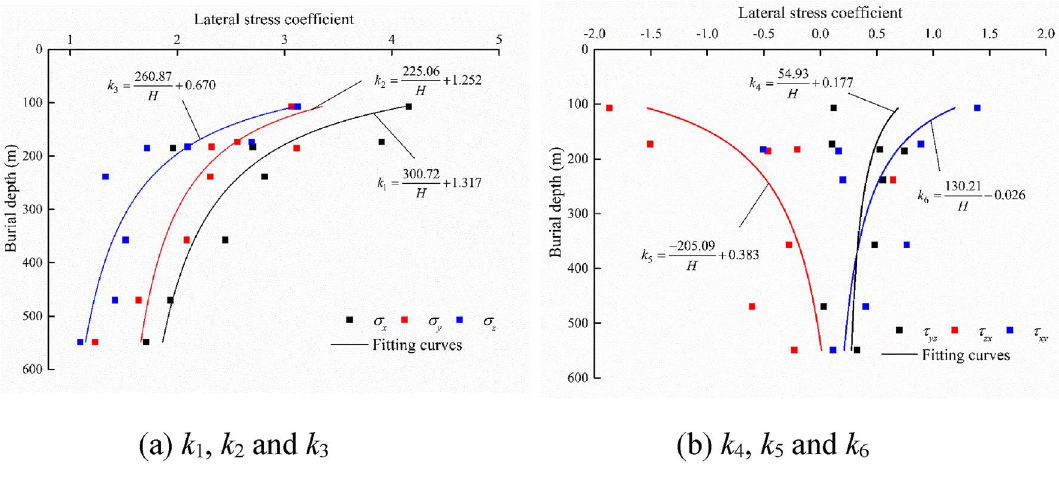
Figure 6. Relationship between burial depth and k i